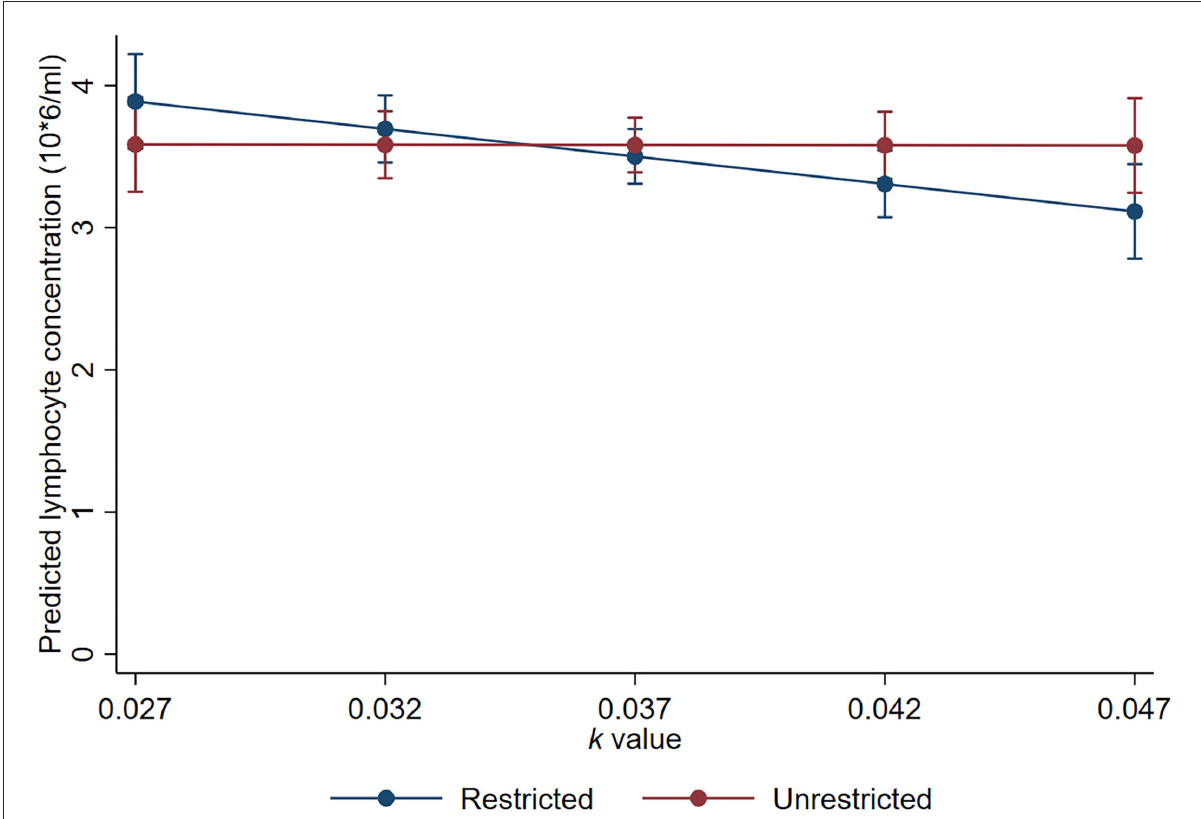
FIGURE7 Linearly predicted lymphocyte concentrations for the interaction between trough allowance and k -value. Error bars represent 95% confidence intervals of predicted